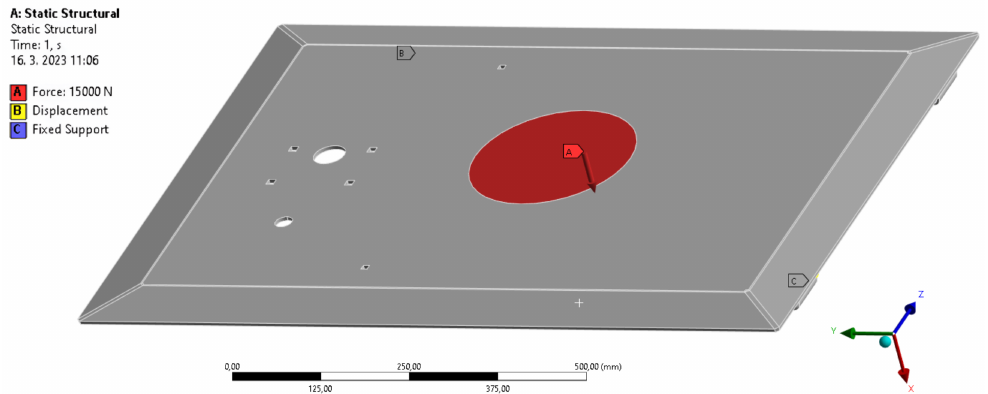
Figure 13. Boundary conditions of the hatch from the top view.